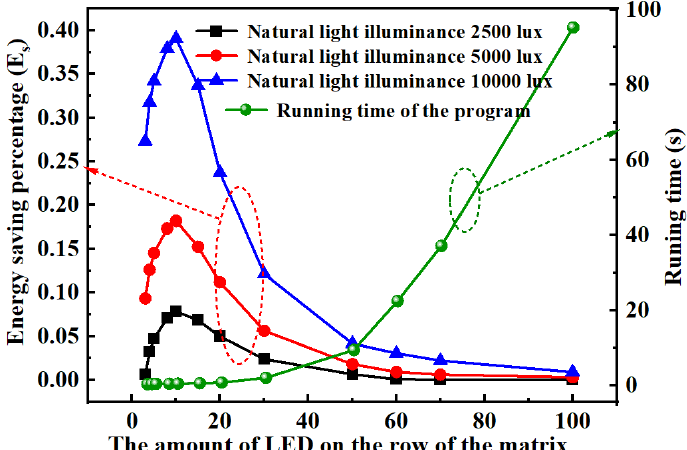
Figure 9. Energy saving percentage ( E s ) of the WLED matrix with different dimensions with natural- light illuminances of 2500 lux, 5000 lux, and 10,000 lux (left axis); the shifting trend of running time of our program with the increase in the matrix dimension (right axis).